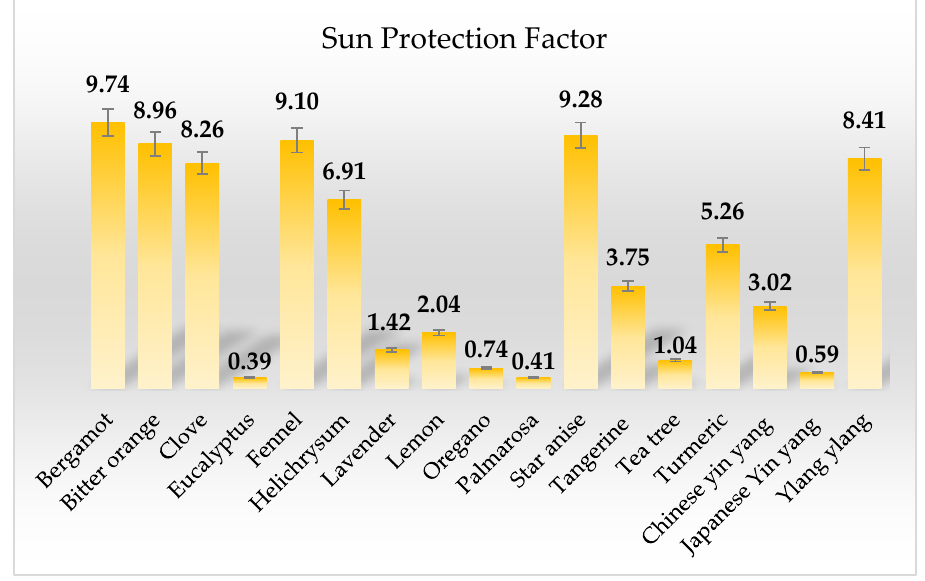
Figure 1. Sun protection factor (SPF) values of EOs.